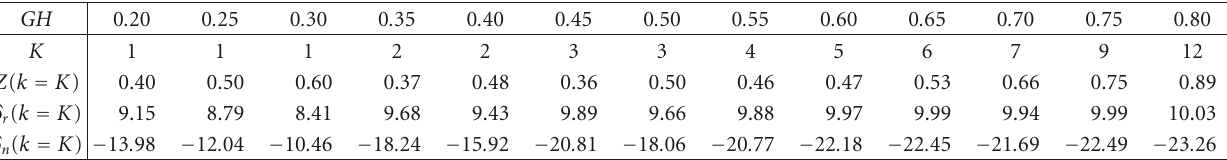
Table 1: Numeric results for the functions GH e , K , Z ( k = K ), δ r ( k = K ), and δ n ( k = K ) applied to the desensitisation. GH 0 . 20 Z ( k = K